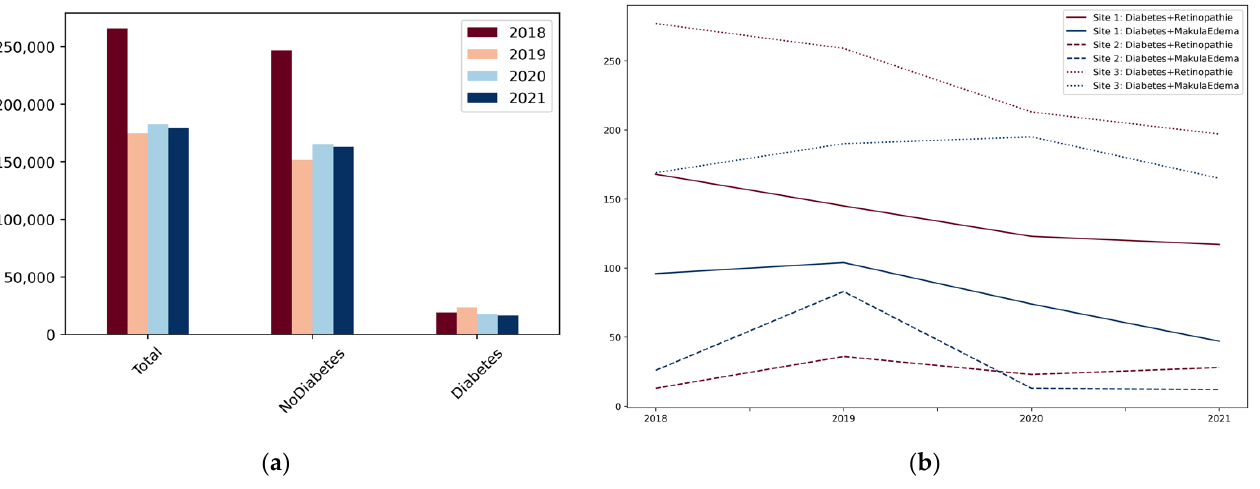
Figure 3. ( a ) Resulting numbers for the total amount of diagnoses, diagnoses other than diabetes and diabetes diagnoses over the years 2018–2021 and over both sites; ( b ) resulting numbers for diagnoses of diabetic related eye diseases.